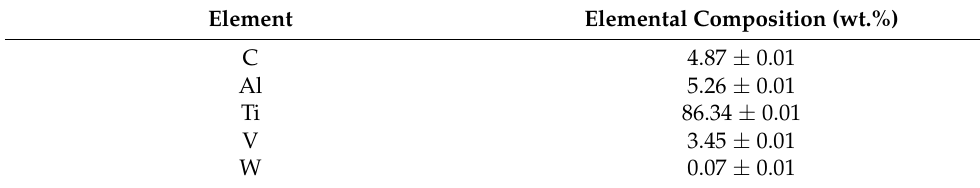
Table 9. Elemental composition of the chip.